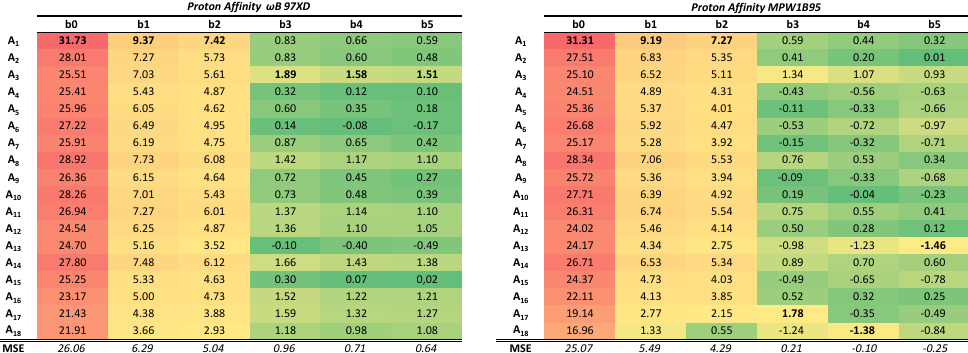
Table 1. Signed relative error values expressed as percentage with respect to the experimental reference value in the calculation of proton affinities (PAs). The results obtained with different basis sets have been colored following a conditional format and a RYG (red–yellow–green) scale in which the worst results are shown in red while the best are highlighted in green. Each density functional has been colored independently to favor the visualization and comparison of the results. The last row represents the mean signed errors (MSE) for each of the basis sets: (b0) : sto-3g, (b1) : 3-21g , (b2) : 6-31g(d), (b3) :